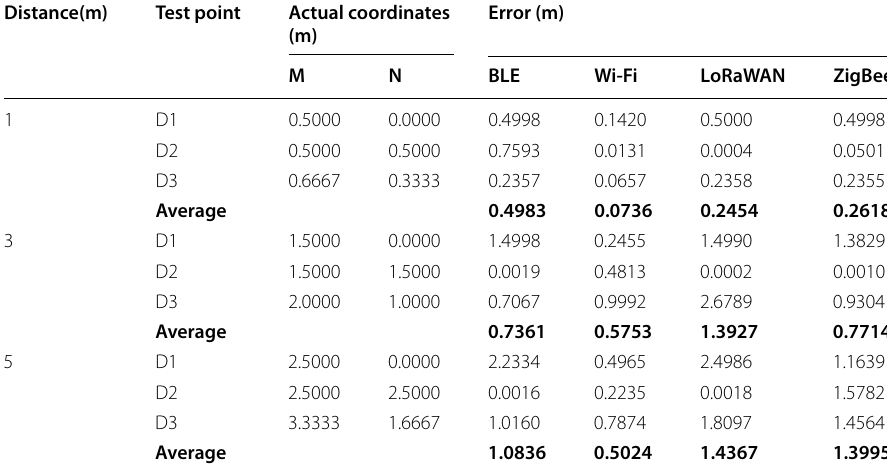
Table 5 MSE values with distances in environment 2 Distance(m) Test point